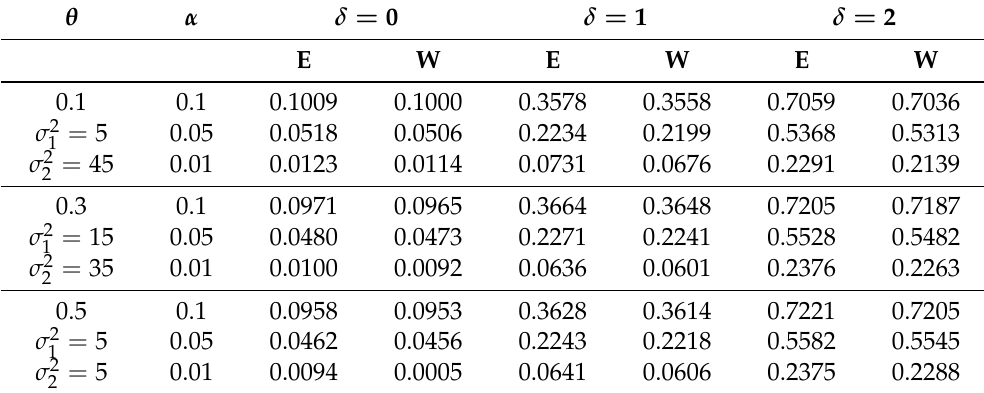
Table 1. Power values for ( n 1 , n 2 ) = ( 5,5 )